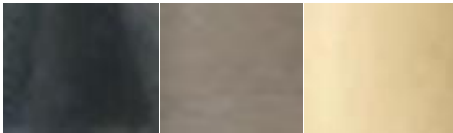
Figure 3. A zoomed view into the colon content: sample 26 (black), sample 35 (yellow, homogenized), and 31 (brown, homogenized).